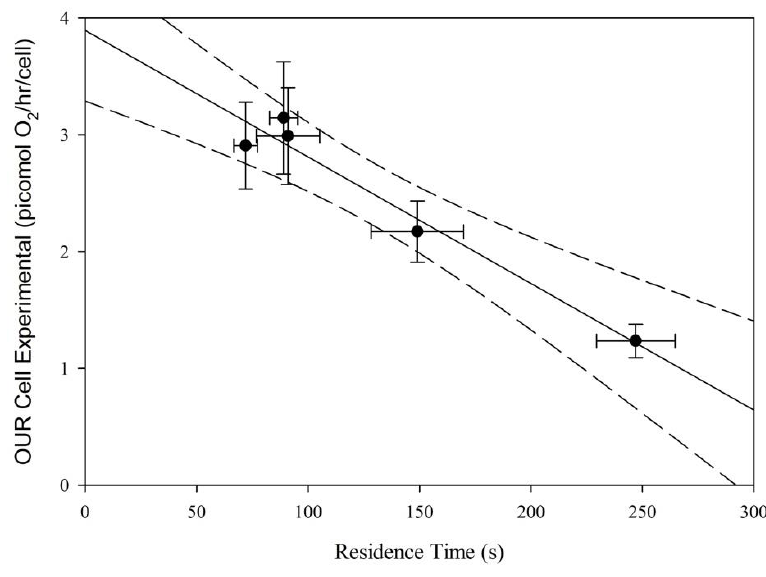
Figure 5. Average observed oxygen uptake rate per cell vs. residence time.